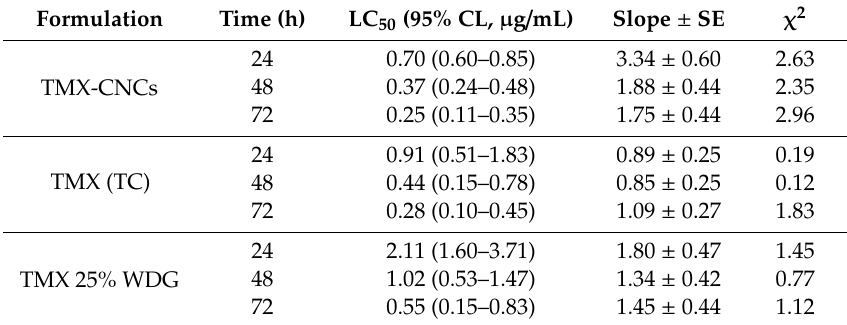
Table 2. Toxicity of TMX formulations against the second instar nymphs of P. solenopsis .